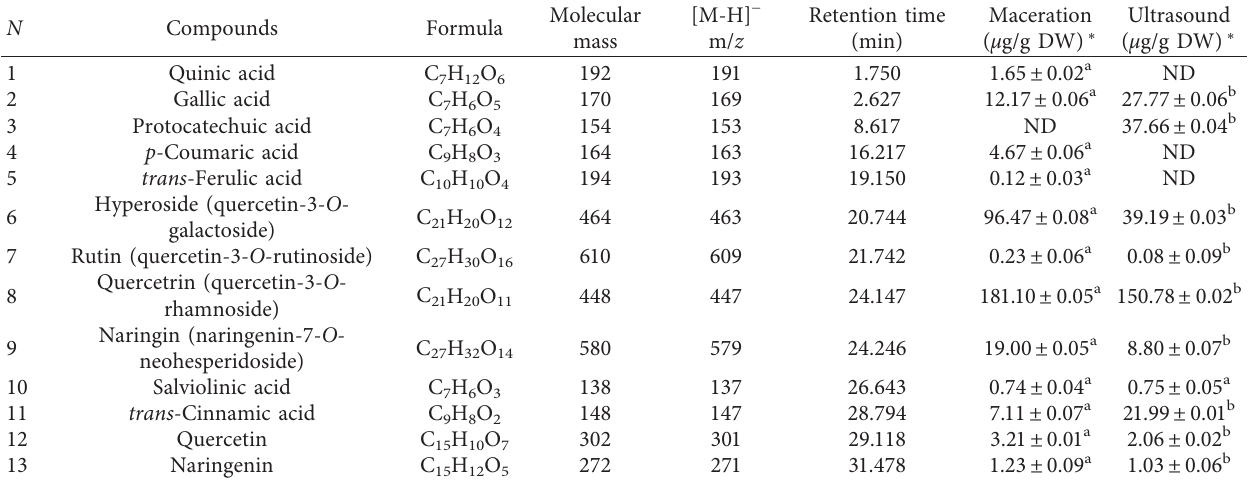
Table 4: Phenolic compounds detected in Eucalyptus marginata L. leaves optimum extraction condition extracts. N